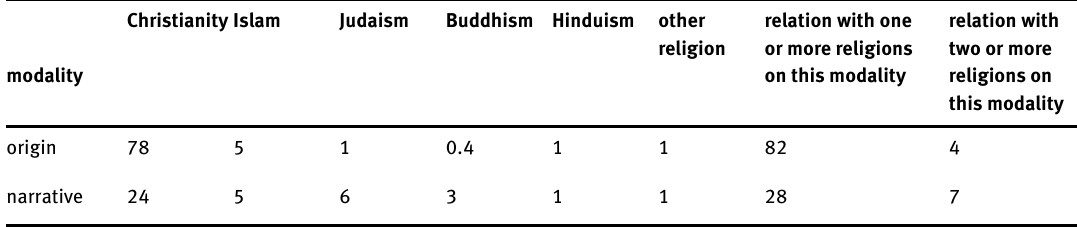
Table 4. Relation with different religions in the modalities of origin and narrative (in per cent of the population).